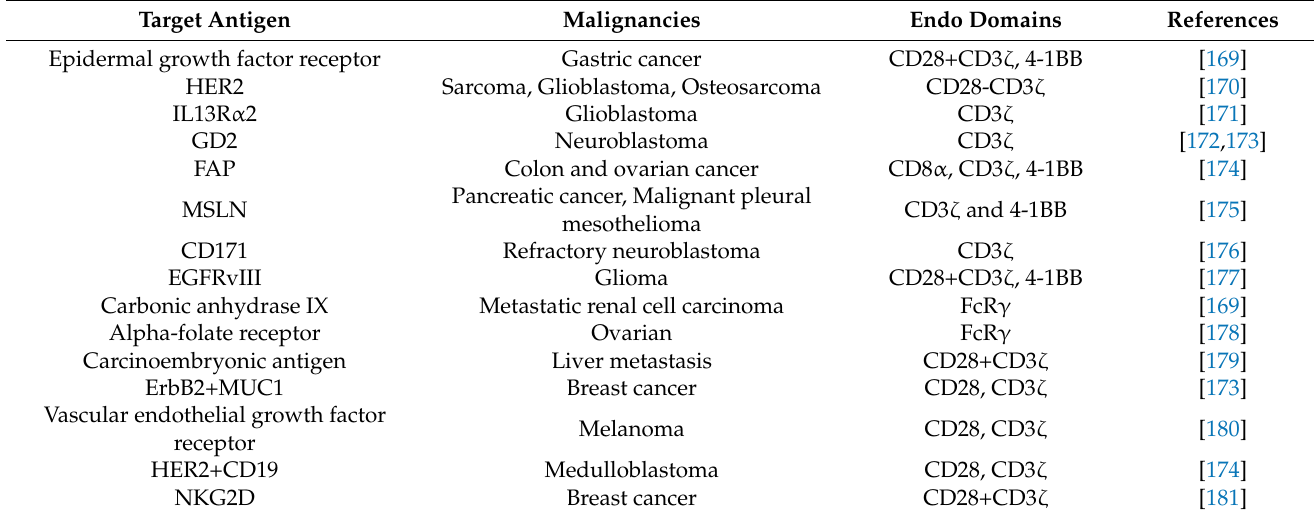
Table 2. Diverse malignancies with their target antigens and their endo domains. Summary of solid tumor antigens targeted by CAR T-cell therapy.